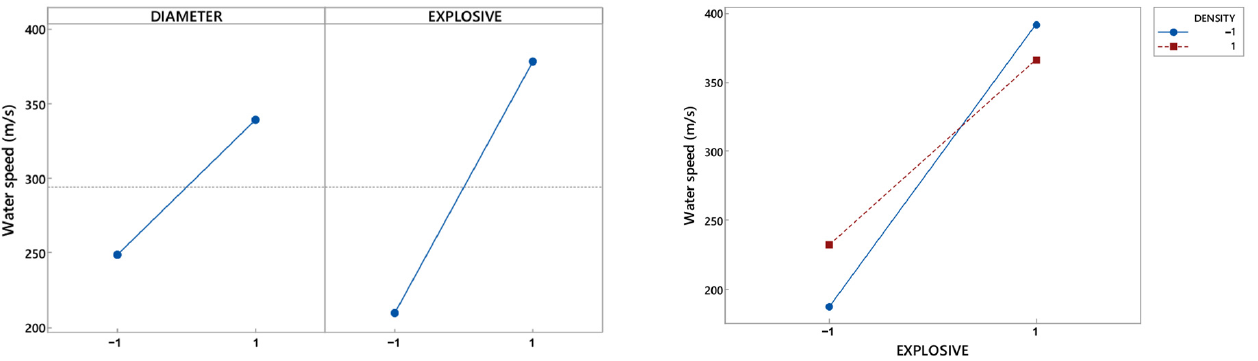
Figure 12. ( Left ): Main effects plot for the “Diameter” and “Mass of Explosive” effects. ( Right ): Interaction plot of “Mass of Explosive” and Figure 12. Left : Main effects plot for the “Diameter” and “Mass of Explosive” effects. Right : Inter- action plot of “Mass of Explosive” and “Density”.